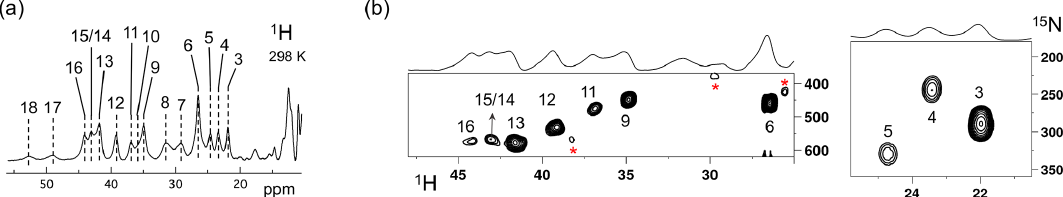
Figure 1. SLAC-T1D NMR spectra at 298K. (a) 1D 1 H WEFT spectrum of SLAC-T1D and (b) 15 N- 1 H HMQC spectra of 15 N-His perdeuterated SLAC-T1D in a back-exchanged environment. The numbering is adopted from Dasgupta et al. (2020a). Noise peaks in the spectrum are marked with a red asterisk. The 1D 1 H WEFT spectrum is shown above the HMQC spectrum.